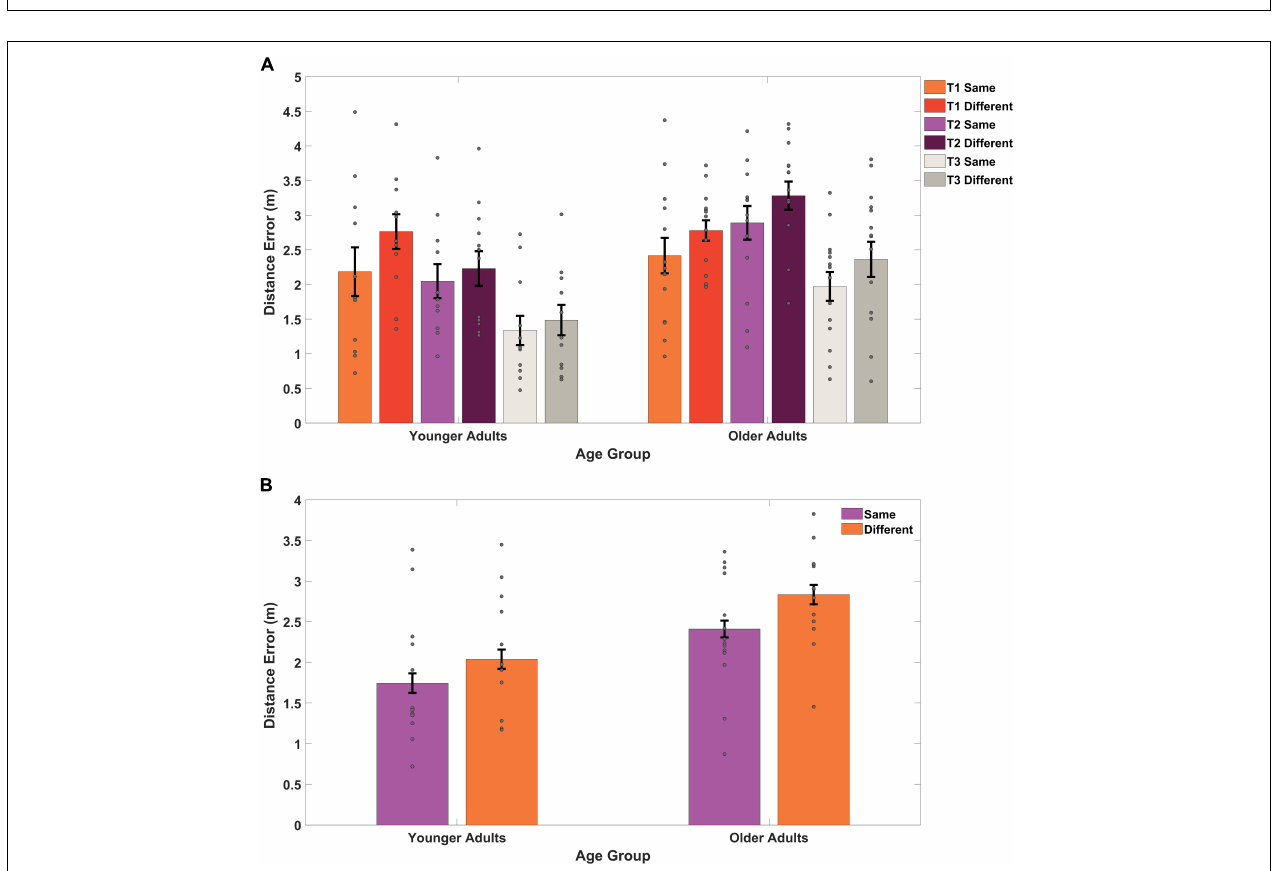
FIGURE 3 | Distance between remembered location and actual location, or distance error, on acquisition trials (A) for each of the three different targets across two different start types (B) , and collapsed across targets for start type. “Same” refers to a repeated viewpoint and “Different” refers to a novel viewpoint. T1 refers to target 1, T2 refers to target 2, and T3 refers to target 3. Gray dots represent individual subject data, bars indicate the mean, and error bars represent the standard error. As a group, older adults remembered the target location as further from its actual location than younger adults.